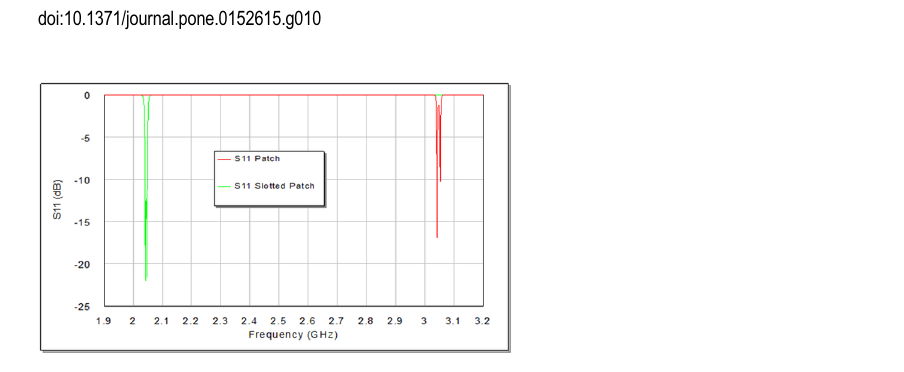
Fig 11. The return loss responses of the two filters; with and without fractal slot. doi:10.1371/journal.pone.0152615.g011 Table 2. Comparative Results between Slotted Patch Filter and the Traditional One.